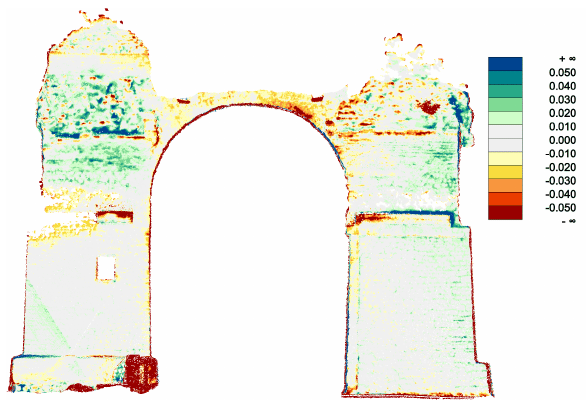
Figure 8: Visualisation of the difference model (units: meter) between the LS and the SfM surface model after LSM adjustment (determination of affine parameters in between the two